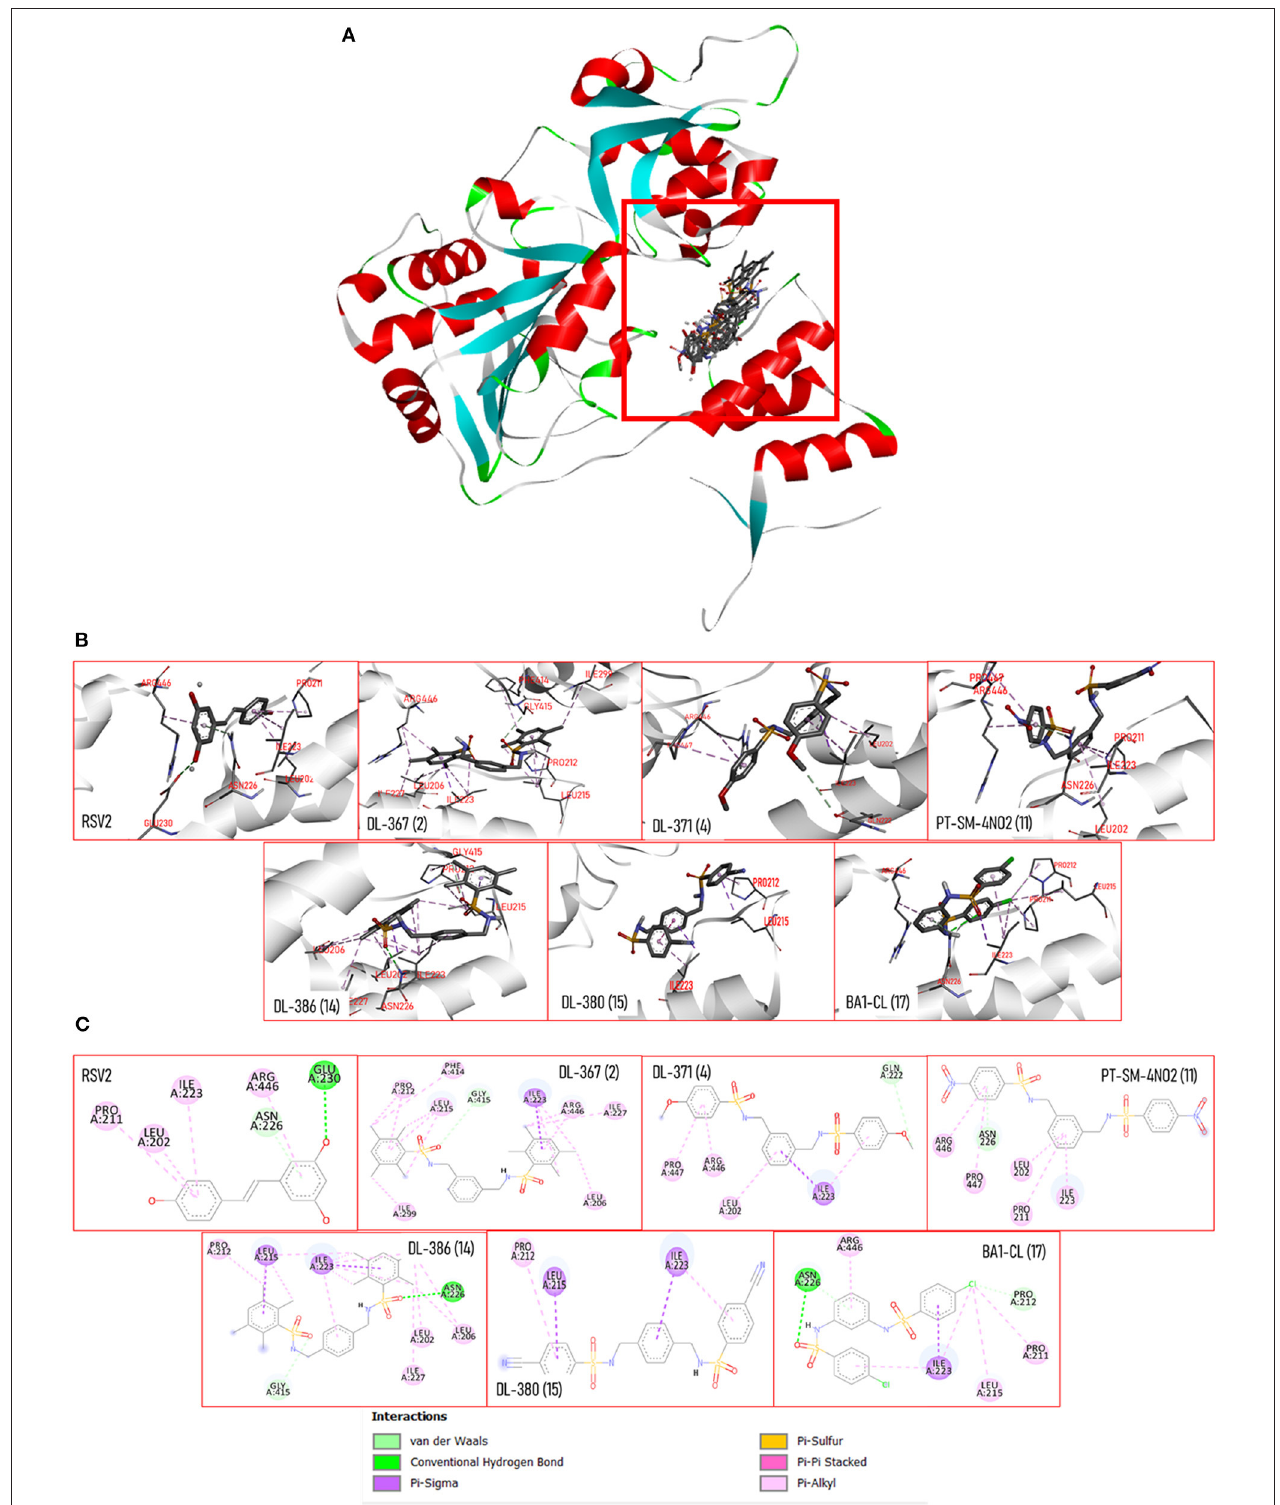
FIGURE 8 | (A) 3D views of the crystal structure of SIRT-1 (PDB: 5BTR) with resveratrol and bis-sulfonamides showing the location of the binding sites. (B) 3D views of SIRT-1 binding interactions with resveratrol and bis-sulfonamides in activator binding site. (C) The 2D protein–ligand interaction diagram of resveratrol and bis-sulfonamides in SIRT-1 activator binding site. The interacting residues are shown as colored circles depending on the type of interaction.